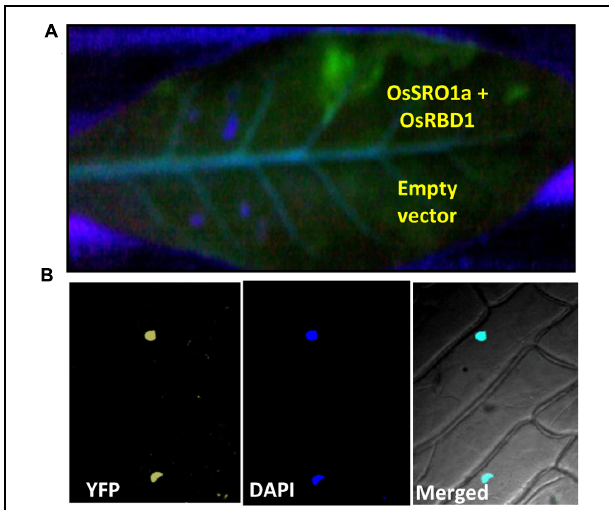
FIGURE 4 | Confirmation of OsSRO1a and OsRBD1 interaction in planta . (A) Agroinfiltration of OsSRO1a-BiFC1 + OsRBD1-BiFC2 constructs in Nicotiana tabacum leaves. Upper side of the midrib shows co-infiltration of OsSRO1a-BiFC1 and OsRBD1-BiFC2 constructs and the lower side shows co-infiltration of BiFC1 and BiFC2 empty vectors. (B) Onion-peel bombardment assay to confirm in vivo interaction between OsRBD1-BiFC1 and